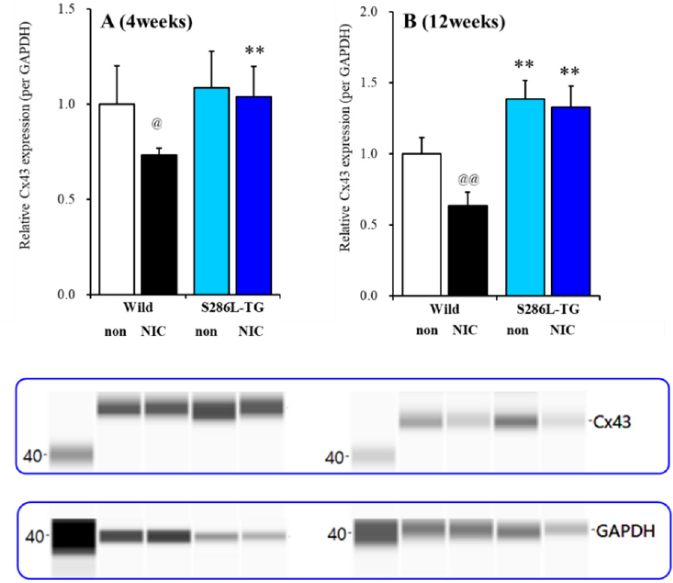
Figure 5. E ff ects of subchronic nicotine administration on connexin43 (Cx43) expression in the OFC. E ff ects of systemic subchronic administration of nicotine (50 mg / kg / day for seven days) on Cx43 expression in the OFC plasma membrane fraction before four weeks of age ( A ), and after 12 weeks of age ( B ), autosomal dominant sleep-related hypermotor epilepsy (ADSHE) onset of the wild-type and S286L-TG and pseudo-gel images from the capillary immunoblotting results, using anti-GAPDH and anti-connexin43 antibodies for blotting of the plasma membrane fractions. Ordinate: mean ± SD ( n = 6) of the relative protein level of Cx43. ** p < 0.01 vs. the wild-type, and @ p < 0.05, @@ p < 0.01 vs. nicotine-free (non) based on a two-way ANOVA with Tukey’s multiple